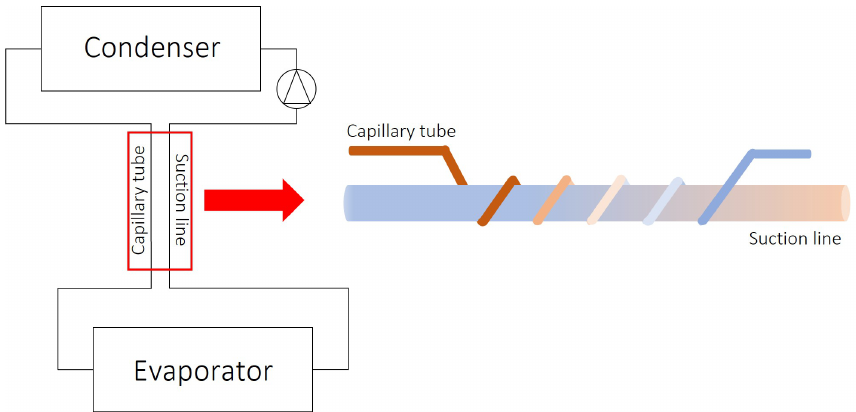
Figure 1. Scheme of a capillary–suction line heat